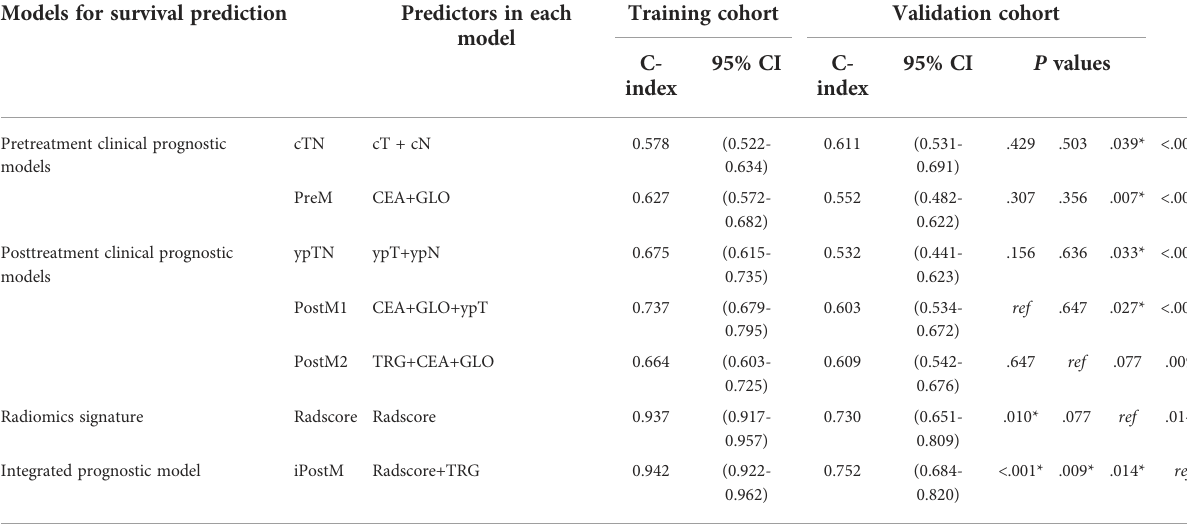
TABLE 2 C-index for each prognostic model for survival prediction.